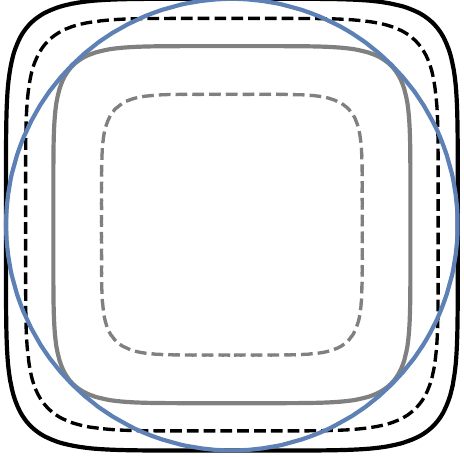
Figure 5 . Illustrative examples of the square-like entanglement cut defined by x 6 + y 6 = c 6 . The dashed gray line is fully contained within the droplet boundary (shown in blue), the solid gray line represents the transition point to a cut that intersects the boundary, the black dashed line is a typical such cut, and the solid black line is at the point where the cut leaves the disk